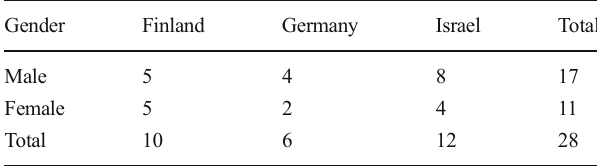
Gender distribution of the focus group participants